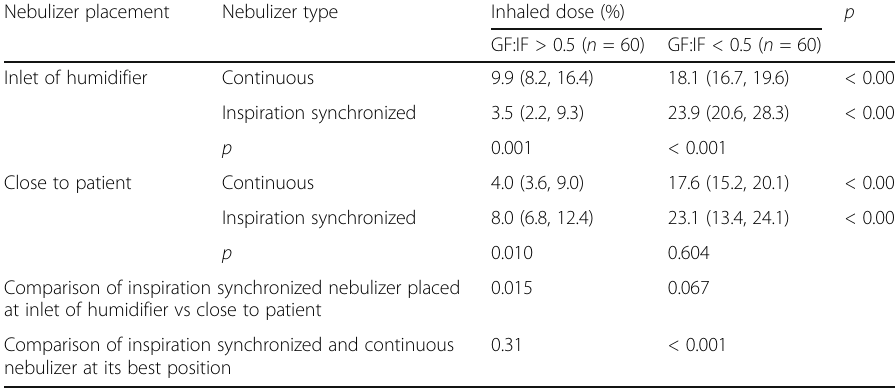
Table 2 Comparison of inspiration synchronized vs continuous nebulizer with different GF:IF and nebulizer